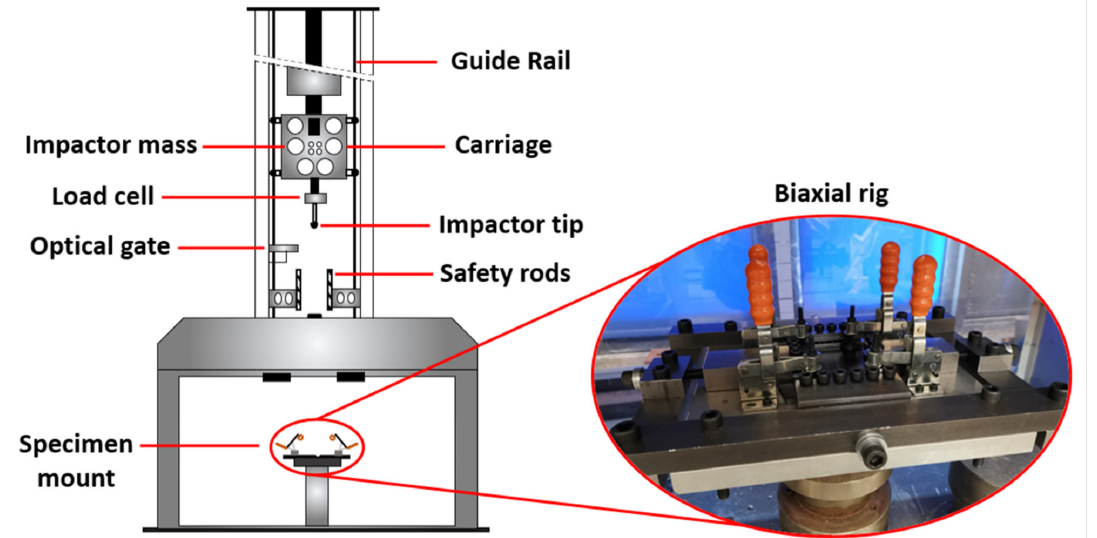
Figure 8. A schematic of the Rosand type 5 instrumented drop-weight impact tester experimental